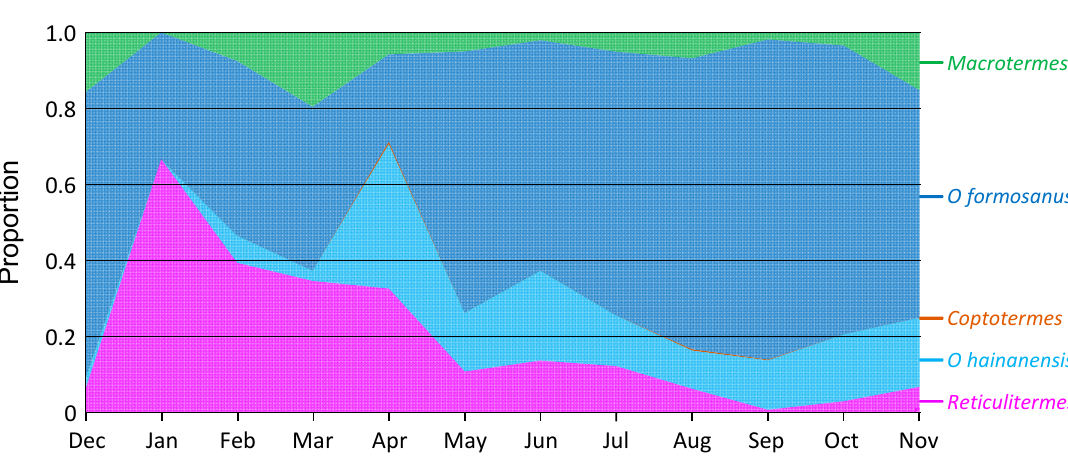
Figure 8. Proportional activity of various termite species in wood containing termites, over one year in Hangzhou Botanical Gardens, China. Data are average ( ± standard error) proportion of dead wood on ground containing each termite species.